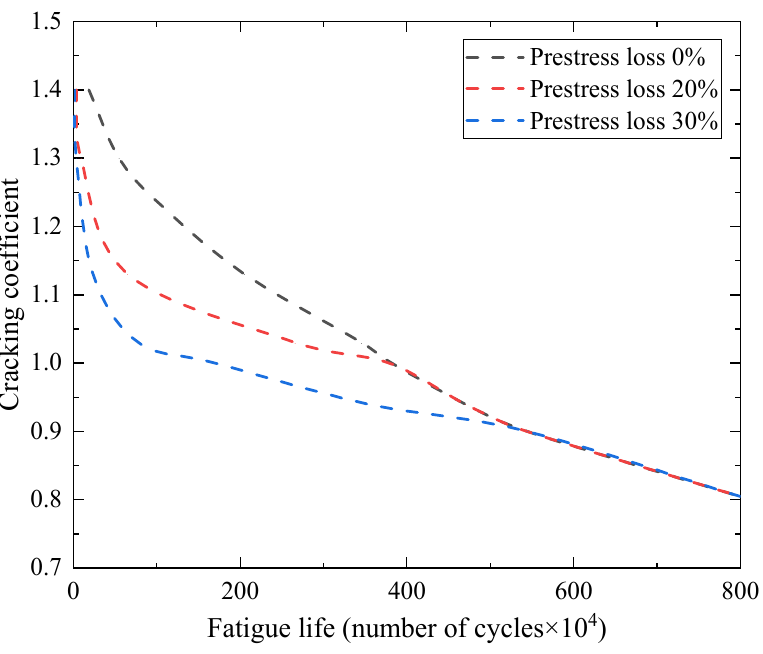
Figure 24. The effect of the fatigue load level and the prestress loss on the fatigue life of the beams.